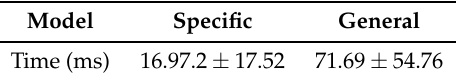
Table 11. Average classification time.